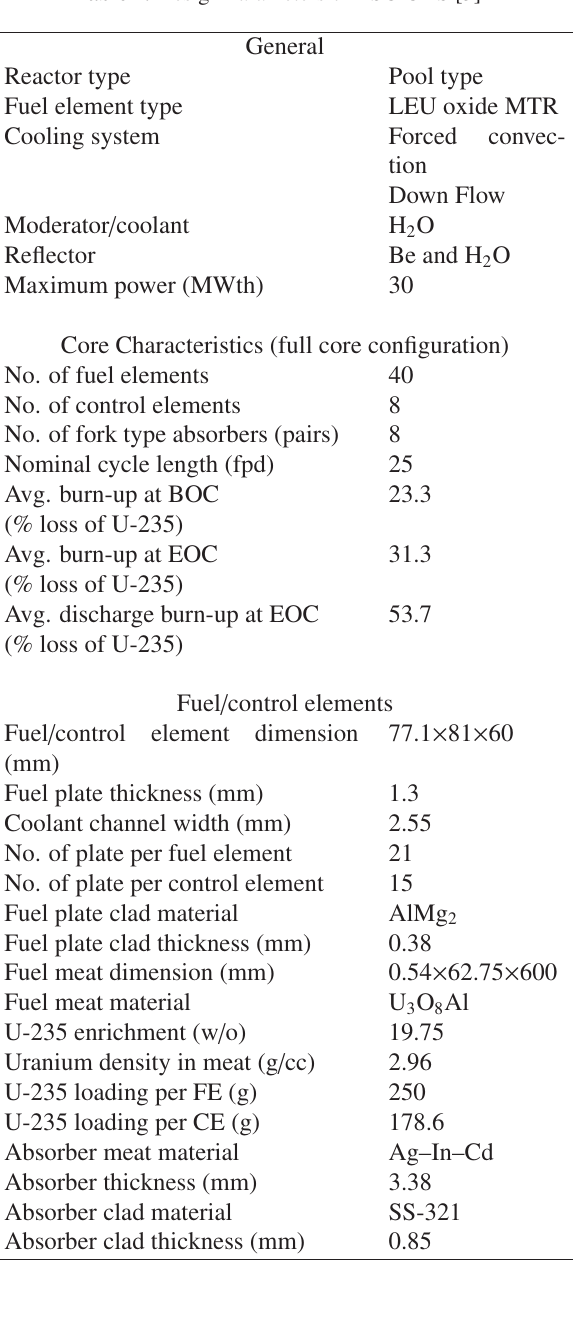
Table 1. Design Parameters of RSG GAS